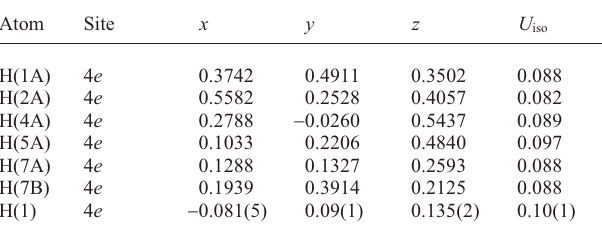
Table 2. Atomic coordinates and displacement parameters (in Å 2 )